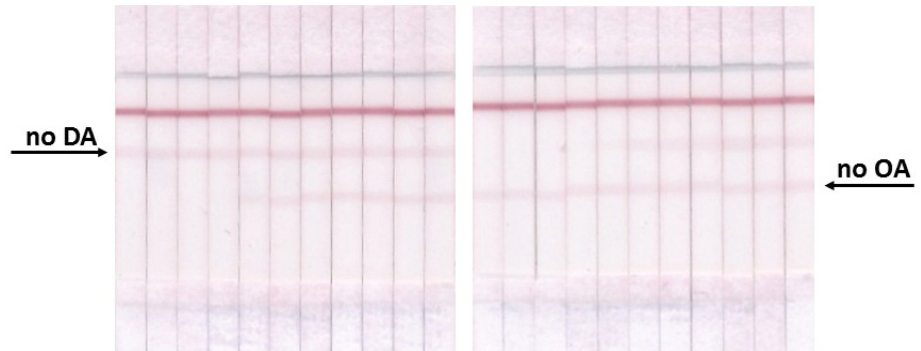
Figure 6. Images of test strips for double ICA in the absence of one of the analytes.